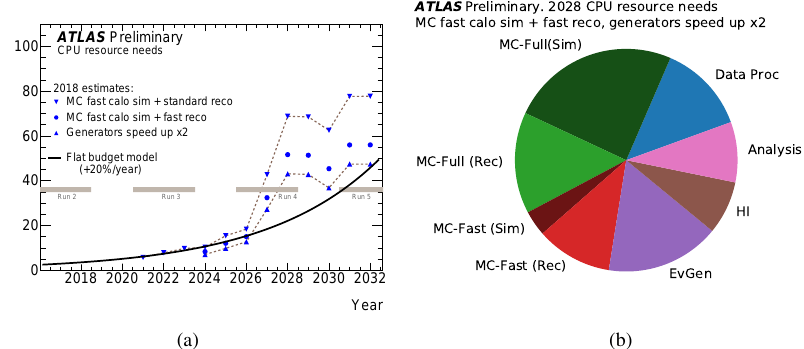
Figure 1: (a) Estimated CPU resources (in MHS06) needed for the years 2018 to 2032 for both data and simulation processing. The blue points show the improvements possible in three di ff erent scenarios, which require significant development work: (1) top curve with fast calo sim used for 75% of the Monte Carlo simulation; (2) middle curve using in addition a faster version of reconstruction; (3) bottom curve, where the time spent in event generation is halved. The solid line shows the amount of resources expected to be available if a flat funding scenario. (b) Fraction of CPU resources needed in 2028 at the end of Run 4 for di ff erent pro- cessing workflows. The ‘MC-Full’ section in green is related to the fraction of time spent on the full Atlas Geant4 simulation and divided in a simulation part ‘(Sim)’ for the Geant4 sim- ulation and a reconstruction part ‘(Rec)’ accounting the time spent reconstructing the events. Similarly, the ‘MC-Fast’ section in red shows this distribution for the time spent running the Fast Calo simulation. Values assume scenario (3)– a faster version of reconstruction and event generation speed-up by a factor of two. Figures taken from ref.